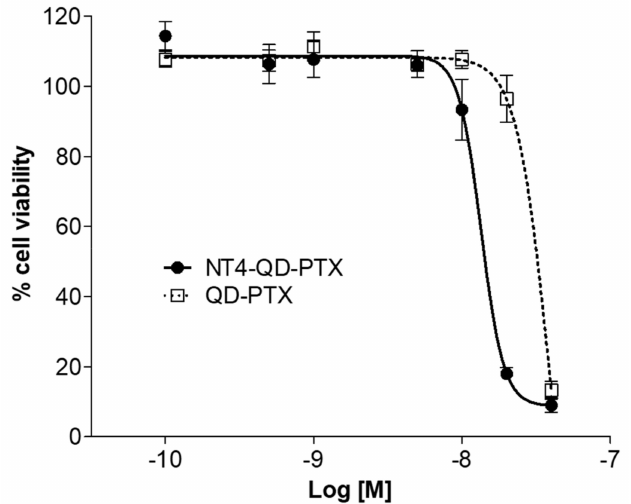
Figure 4. Cytotoxicity of NT4-QD-PTX in HT-29 cell line. Cytotoxicity of NT4-QD-PTX (black line) was compared with that of the unlabeled QDs conjugated with paclitaxel (QD-PTX; dotted